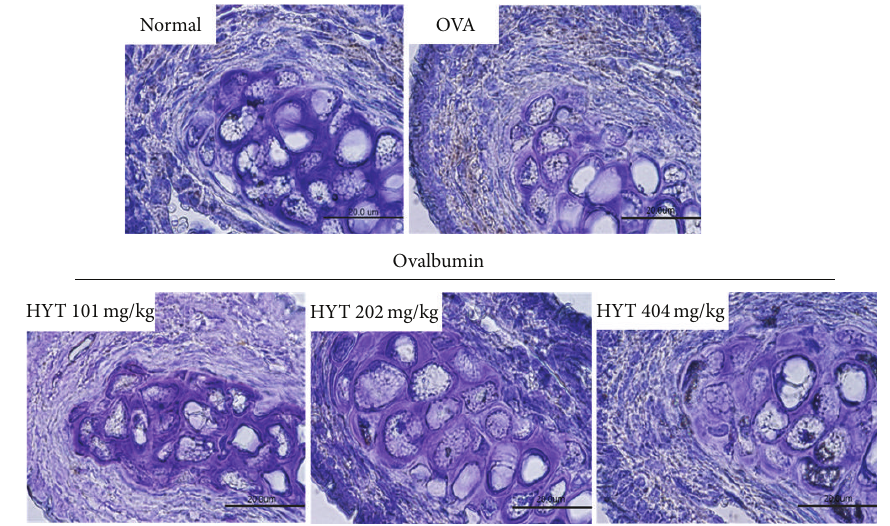
Figure 5: Distribution of CD4+ cells in nasal cavity samples. The nasal cavity sections were immunostained with CD4+ antibody. CD4+ cells show a brown color. Sections were evaluated using microscope at an original magnification of